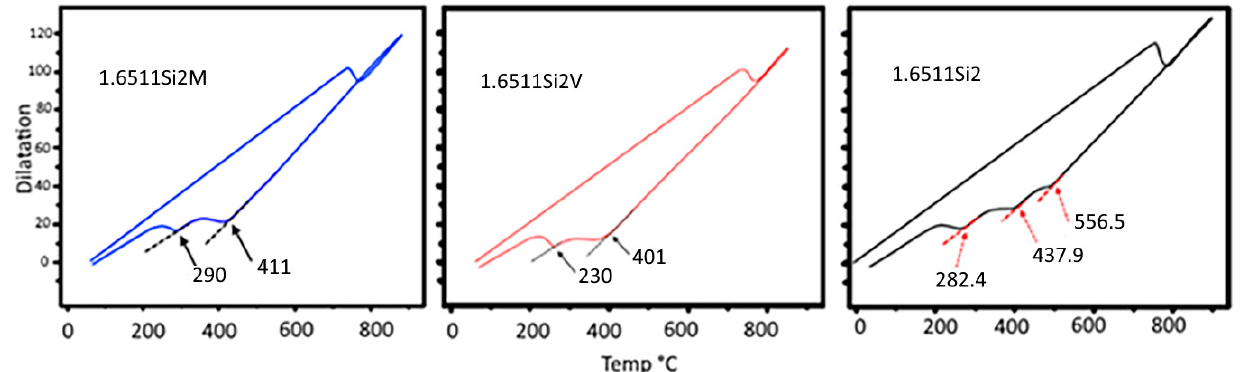
Figure 4. Dilatometric test results of the silicon-modified alloy (1.6511Si2), silicon-modified alloy after adding vanadium (1.6511Si2V), and silicon-modified alloy after adding a rare earth alloy (1.6511Si2M) at a continuous cooling rate of 4 °C/s .